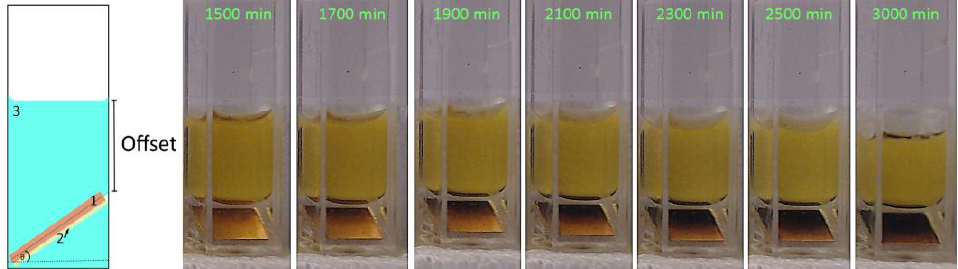
Figure 7. Course of the bulk diffusion experiment. After 1500 min, the indicator-plate begins to blacken, confirming a certain concentration has reached the upper edge of the plate. After 3000 min the critical concentration reaches the bottom of the cuvette.